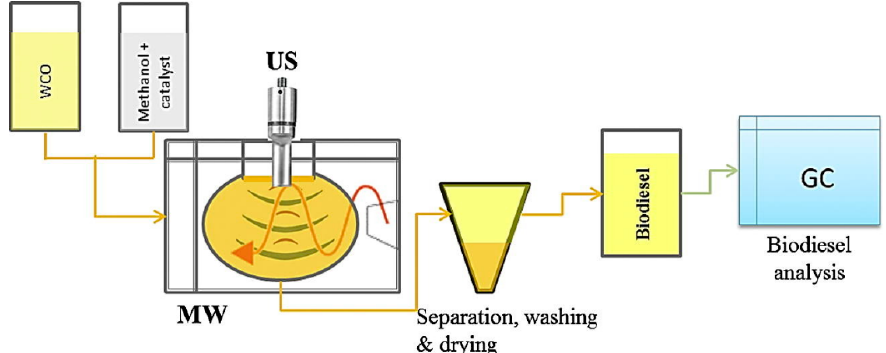
Figure 5. Synergistic effect of simultaneous MW and US irradiation on the transesterification of waste vegetable oil [32].